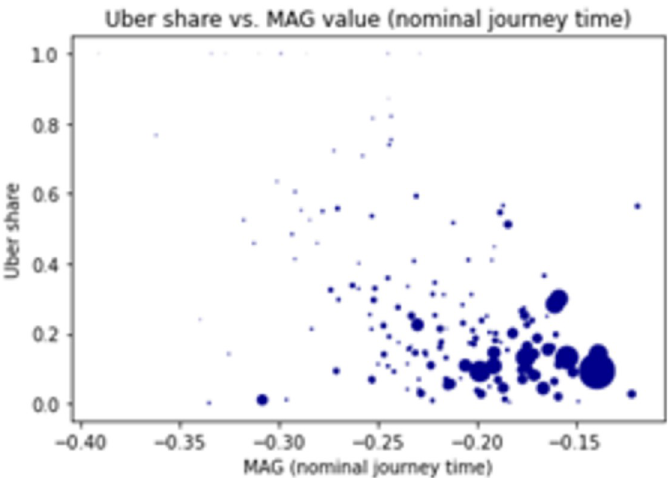
Fig 6. Scatter plots relations between the share of Uber demand (as a fraction of Uber and public transport demand) and the modal accessibility gap for nominal journey time. Each dot represents a hex in Washington DC and its size corresponds to the total demand for public transport and Uber originating from that